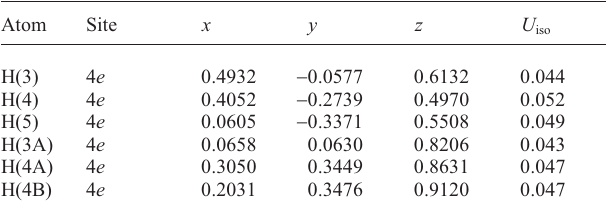
Table 1. Data collection and handling. Table 2. Atomic coordinates and displacement parameters (in Å 2 )